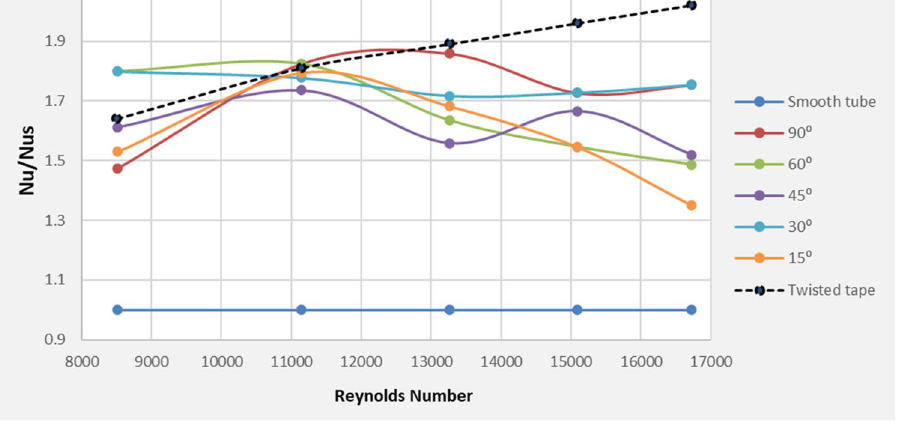
Fig. 14 Comparison of heat transfer enhancement effi- ciency (Nu/Nus) between MIs (MIs angle = 45° and P/D = 4) and Twisted tape